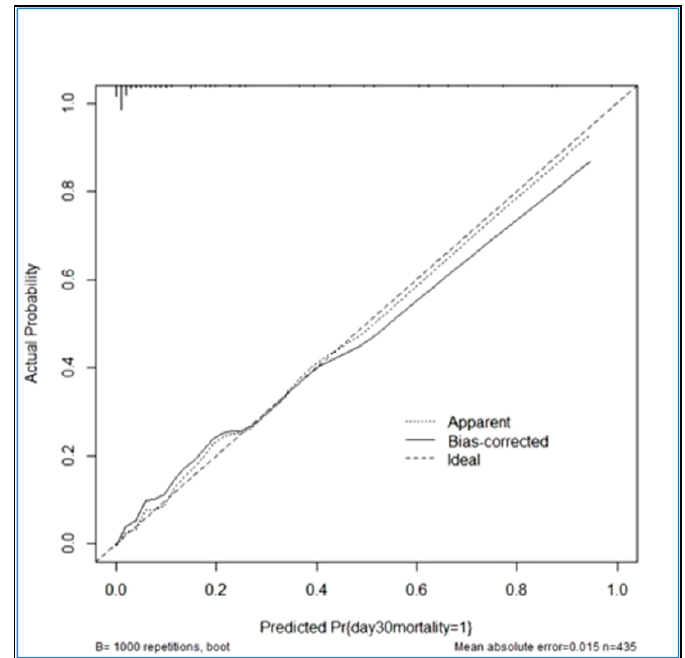
Figure 6. Model calibration graph by bootstrapping method. The Y -axis represents the actual probability of postoperative death. The X -axis rep- resents the predicted probability of postoperative death. The ideal line is a perfect predic- tion model. The apparent line represents the performance of the model, and a close match to the ideal line is a good prediction, as seen in our calibration graph. The BS value is 0.053 < null model (0.103) and less than 0.25, which confirms the accuracy of the prediction. A clinical score (called Mortality Score—Clinic County Emergency Hospital of Gala ț i/OCC) was built based on the nine predictors, in which we assigned 1 point to each of the predictors. Thus, the score for the patients in the group varied between 0 and 6 points (the maximum number of factors present in one patient was 6). To evaluate the performance of the score, we generated an ROC curve. The calculated AUC for this model was 0.932 (95%CI = 0.922–0.972, p < 0.001), which showed an excellent discriminatory power of the values predicted for postoperative mortality. With the optimal cutoff value > 2 factors, the score identified 96.1% of the cases that died and can identify 73.7% among the survivors. Patients with more than two factors for mortality risk constitute the high- risk group (Figure 7). Figure 7. ROC curve—Mortality Score—Clinic County Emergency Hospital of Gala ț i/OCC.